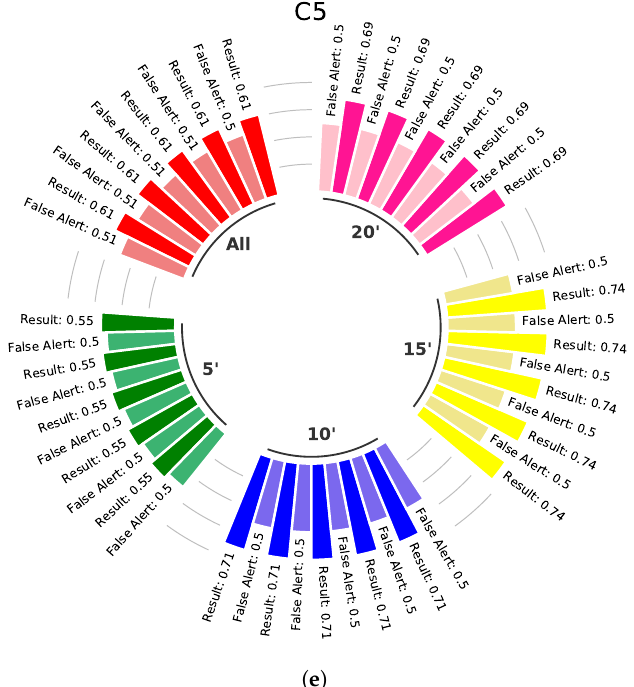
Figure 16. Performance of combinations at different time intervals between each of the proposed ap- proaches when it’s configured with their best variable values. ( a ) Performance of C 1. ( b ) Performance of C 2. ( c ) Performance of C 3. ( d ) Performance of C 4. ( e ) Performance of C 5. Table 4. Maximums and Minimums of the performances of the five combinations with the variables identified for each